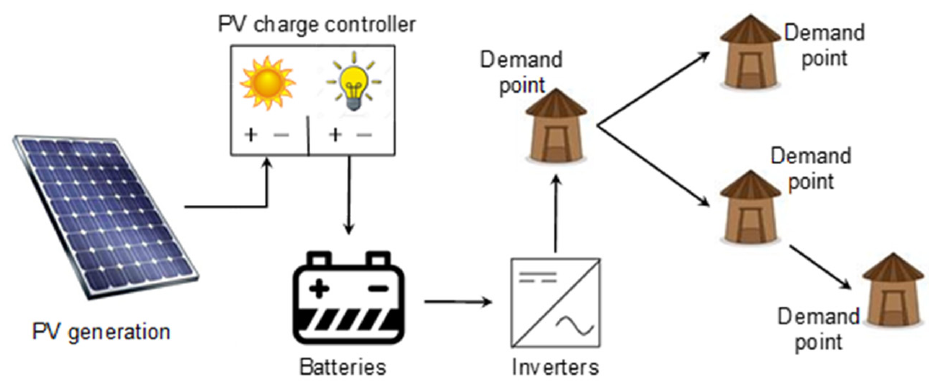
Figure 1. Scheme of a PV system with microgrid distribution.